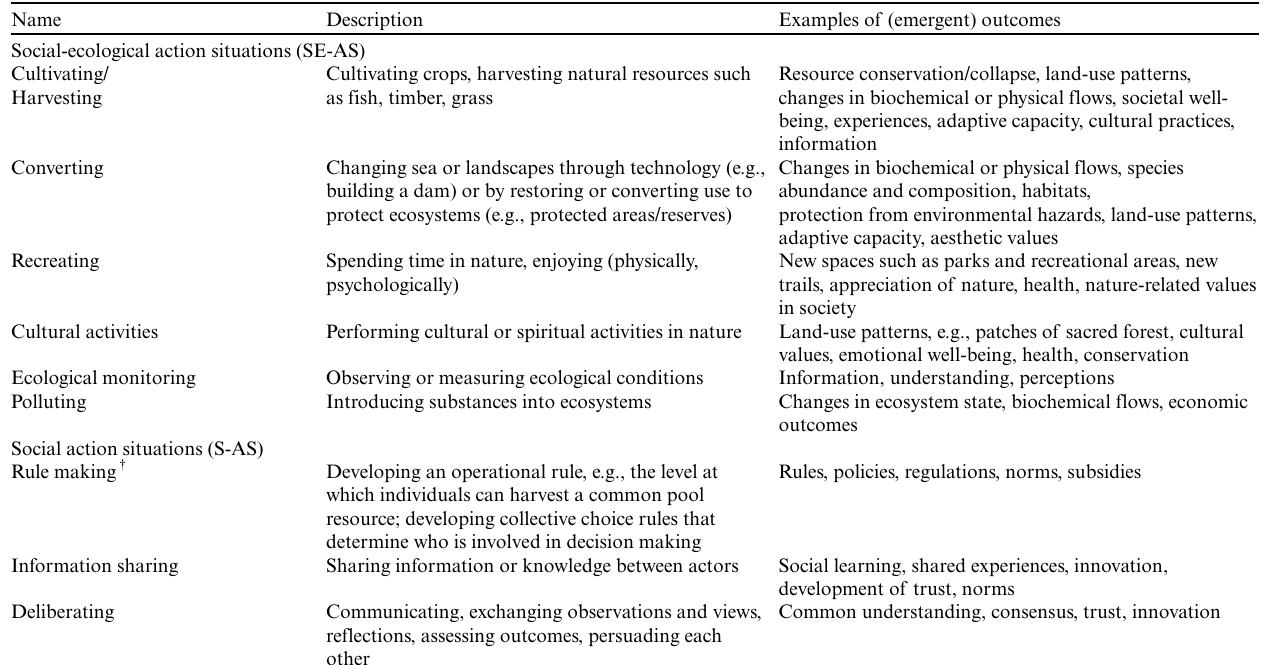
Table 1 . Types of social-ecological, social, and ecological action situations (social action situations expand from McGinnis and Ostrom 2014). The list is not intended to be comprehensive but a starting point for identifying action